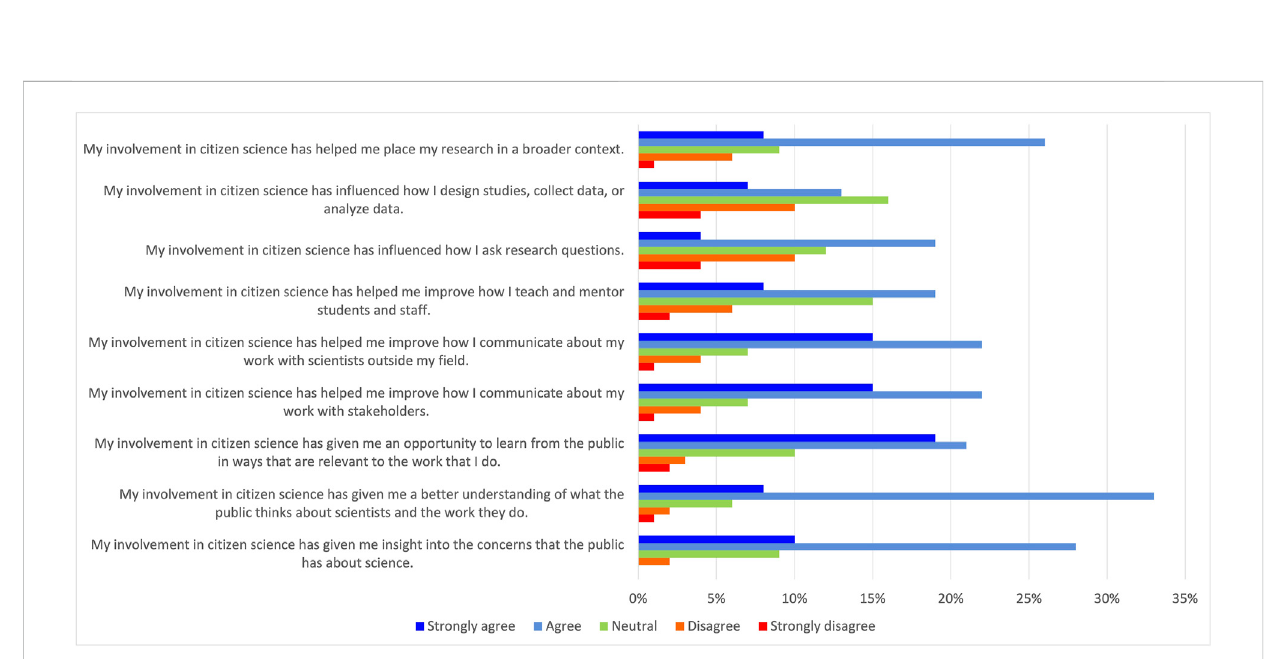
FIGURE 5 Percentage of respondents who rated different ways the CS initiative impacted